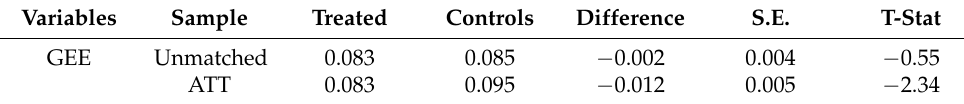
Table A7. Average treatment effect on the treated: 1:4. Variables Sample